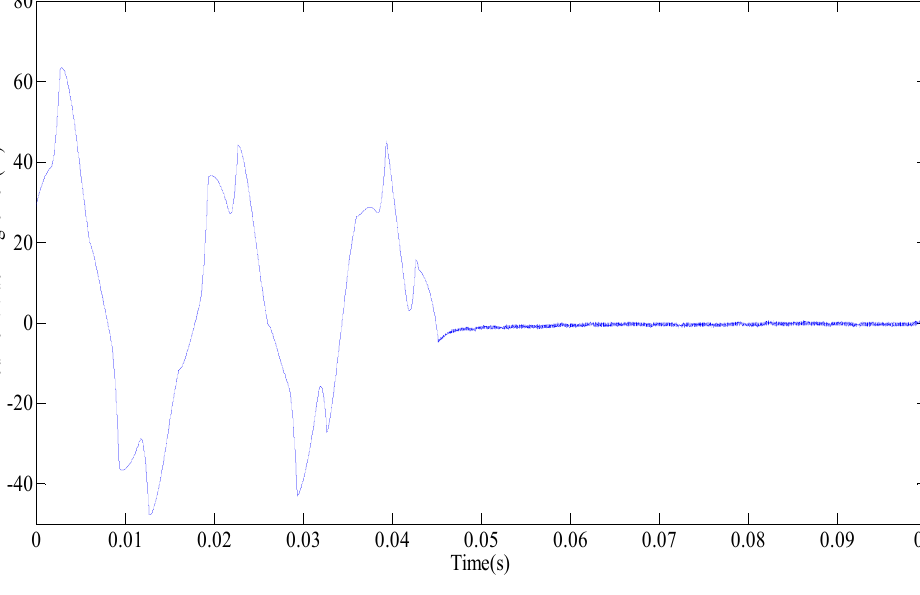
Figure 6. Compensation current tracking error.